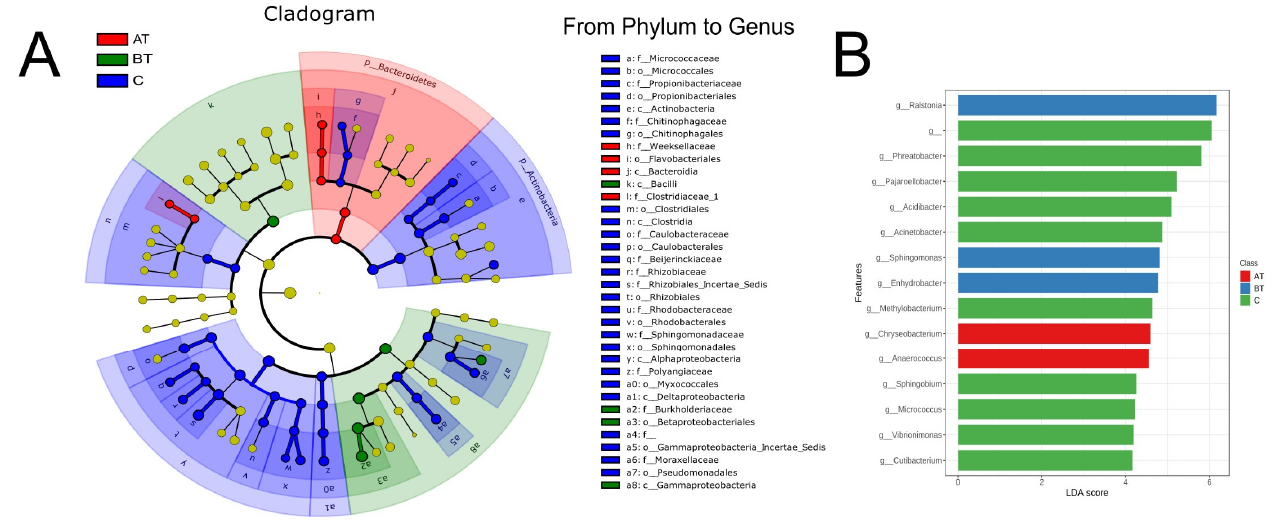
Figure 7. LEfSe analysis of the facial microbiota of pre-treated (BT), treated (AT), and control (C) acne groups. ( A) : Cladogram representation of statistically consistent differences (Phylum—genus) in the three groups. Each circle’s diameter is in proportion to that taxon’s abundance. ( B ): Enriched genera (LDA > 3.5) in the three groups.